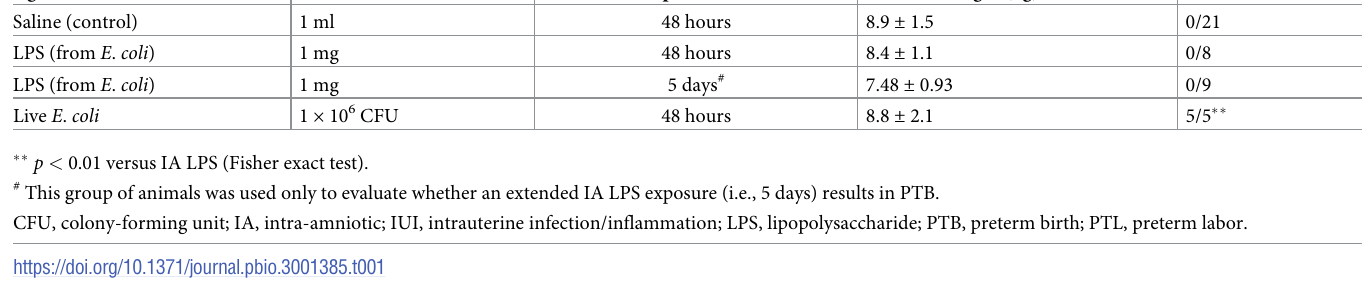
PTL in humans [30,31].